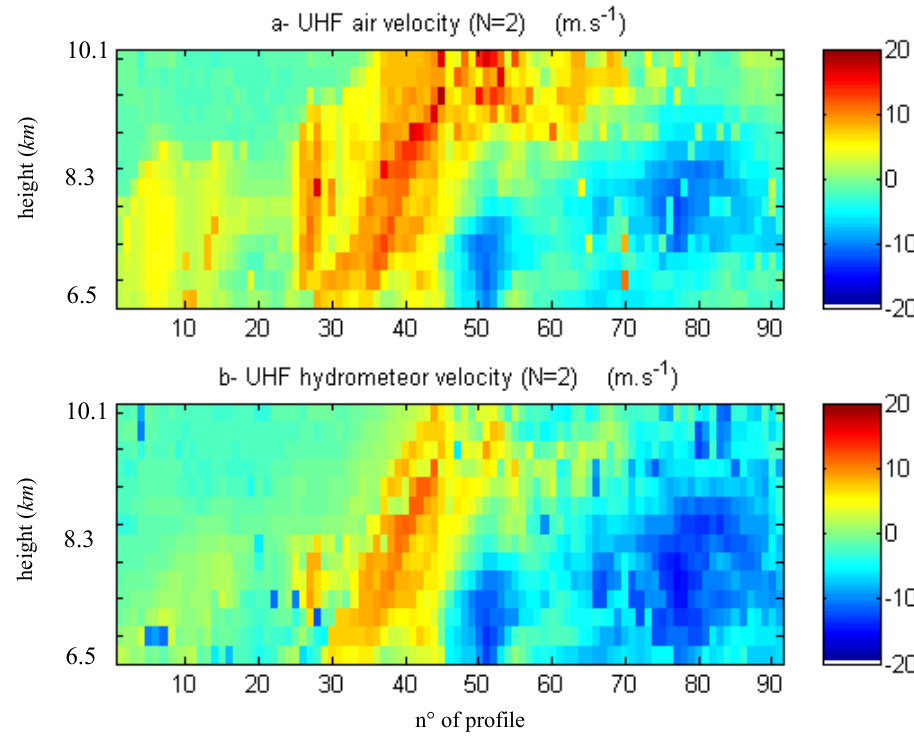
Fig. 5. Doppler radial velocity of hydrometeor and air estimated from UHF time series, assuming N = 2